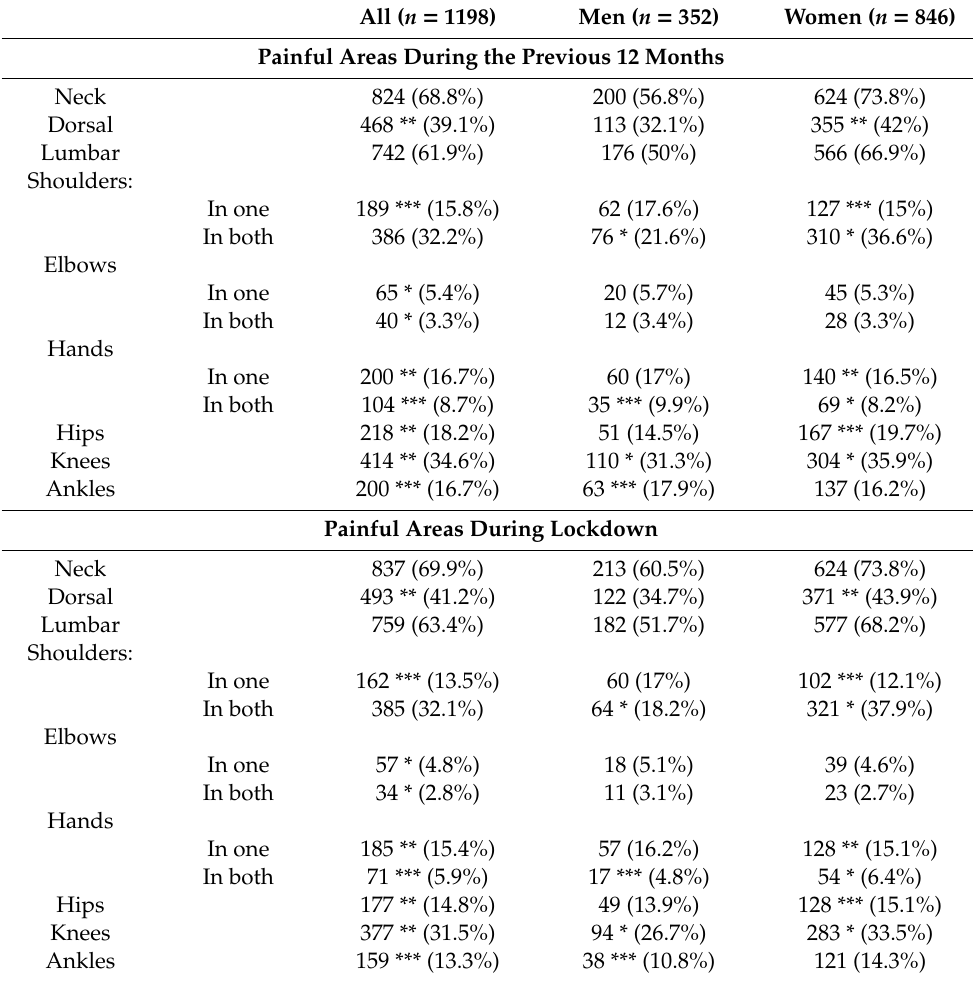
Table 2. Prevalence of pain during the year prior to the lockdown and during it (data provided in (percentage)). All ( n = 1198) Men ( n = 352) Women ( n = 846) Painful Areas During the Previous 12 Months Neck 824 (68.8%) 200 (56.8%) 624 (73.8%) Dorsal 468 **